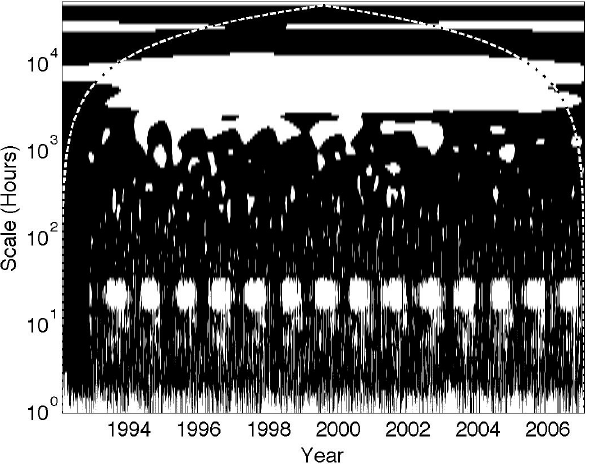
Fig. 1. Wavelet coherence between Harvard Forest (US-Ha1) net ecosystem exchange of CO 2 (NEE) observations and Ecosystem Demography 2 (ED2) model simulations along the time and scale axes. The model was not run for the first year of measurements for the North American Carbon Program Site-Level Interim Synthesis. The black line is the cone of influence beyond which wavelet coef- ficients should not be interpreted.